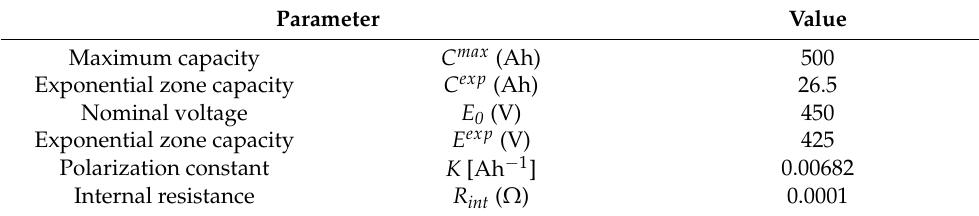
Table 2. Li-ion battery